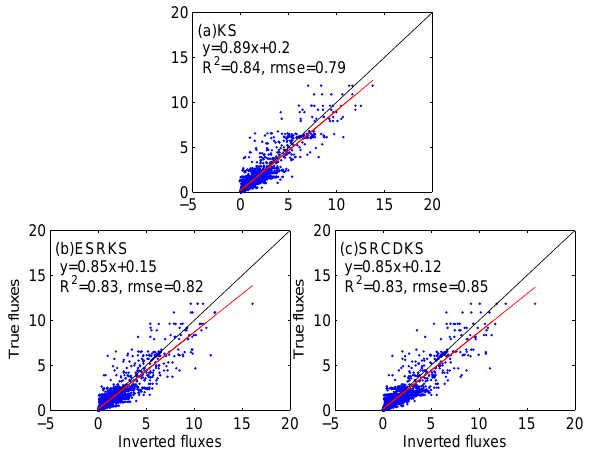
Fig. 4. Inversion results from the interval constrained inversion us- ing different methods. A lag length of 7 and a correlation length of 0 are used for all Kalman update smoothers. The ensemble size for ESRKS is 500, and that for SRCDKS is 101. The red lines are the linear regressions of the inversions against the true fluxes.